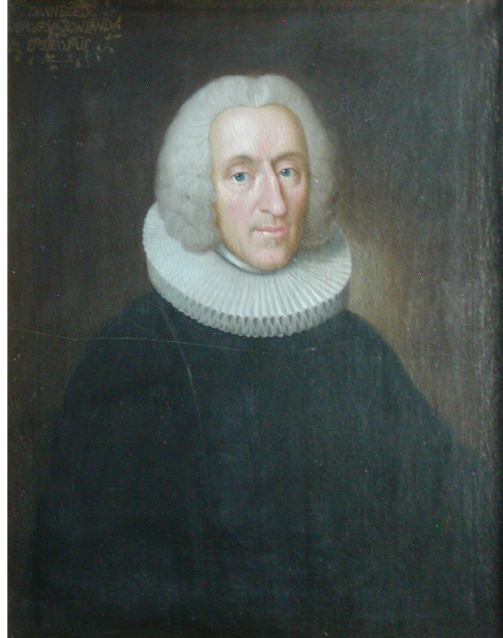
Figure 4. Hans Egede (1686–1758) (Frederiksborg Museum).